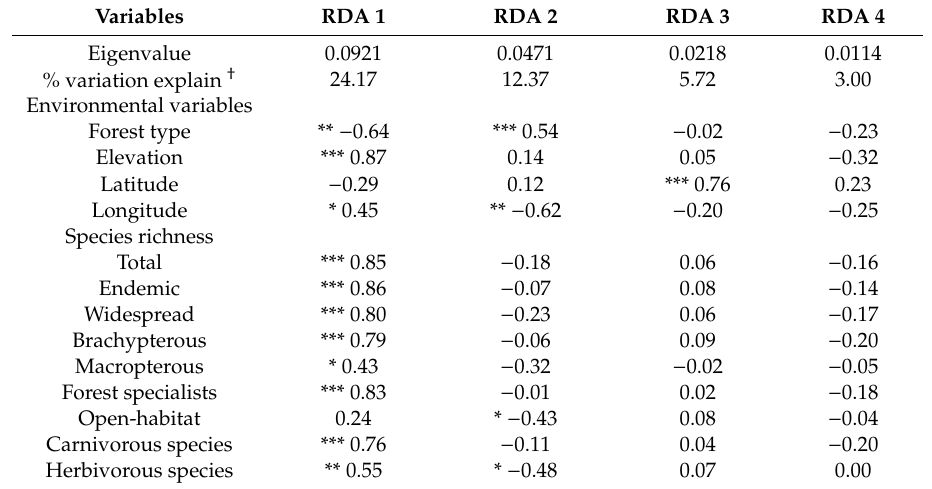
† Percentage = 100 × (variation explained by respective axis) / (variation explained by all environmental variables). Statistically significant correlations are indicated by * p < 0.05, ** p < 0.01, *** p <